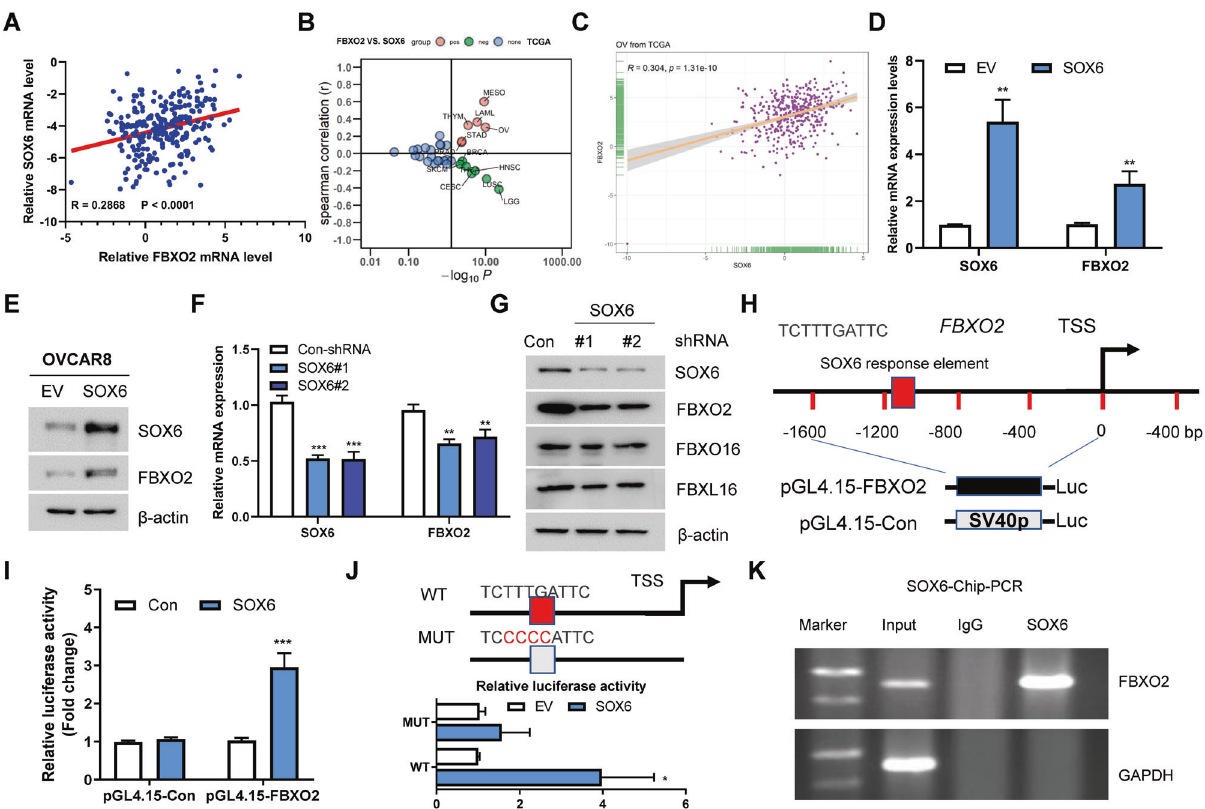
Fig. 2 SOX6 functions as a positive regulator of FBXO2. A The mRNA expression correlation between FBXO2 and SOX6 in GSE32062 dataset. B The spearman correlation between the expression of FBXO2 and SOX6 in all tumor types in TCGA. Red represents positive expression and green represents negative expression. C The mRNA expression correlation between FBXO2 and SOX6 in OV from TCGA database. D , E The mRNA and protein levels of FBXO2 and SOX6 in A2780 cells transfected with indicated plasmids were determined by real-time PCR and immunoblotting, respectively. F , G The mRNA and protein levels of FBXO2 and SOX6 in A2780 cells transfected with Con-shRNA or SOX6- shRNA were determined by real-time PCR and immunoblotting, respectively. H Schematic diagram shows human FBXO2 gene promoter and one putative SOX6 binding site. TSS: transcription start site. I pGL4.15-Con or pGL4.15-FBXO2 plasmids were co-transfected with either FLAG- Con or FLAG-SOX6 into 293T cells for 36 h. The luciferase activity was then measured. J The human FBXO2 promoter contains one potential binding site for SOX6 was highlighted with RED. The mutant site was labeled with gray. FLAG-SOX6 was co-transfected with pGL4.15-Con or pGL4.15-FBXO2 plasmids into 293T cells for 36 h. The luciferase activity was then measured. K ChIP assay shows enrichment of SOX6 at the human FBXO2 promoter in A2780